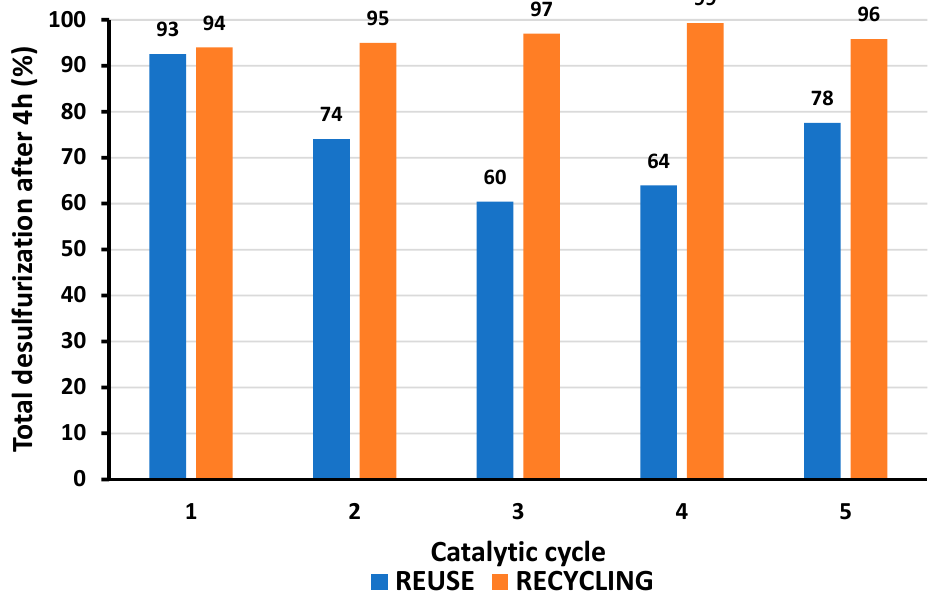
Figure 6. Reusability and recycling results obtained after 4 h using a biphasic model fuel/[BMIM]PF 6 as extraction solvent and the solid EuW 10 @ZIF-8 catalyst (containing 3 µ mol of EuW 10 active center), using 75 µ L of H 2 O 2 as oxidant, at 70 ◦